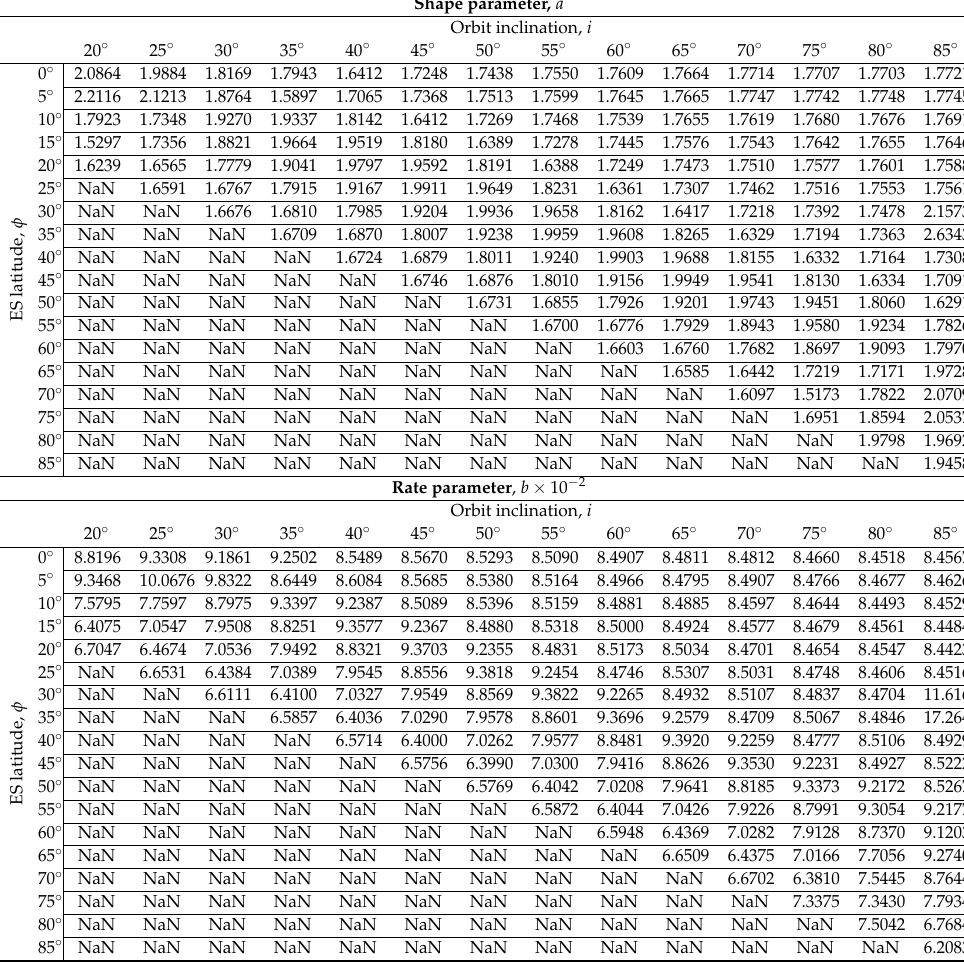
Table A5. Shape, a , and rate, b parameter for f Θ ( θ ) and F Θ ( θ ) for h k = 1800 km.